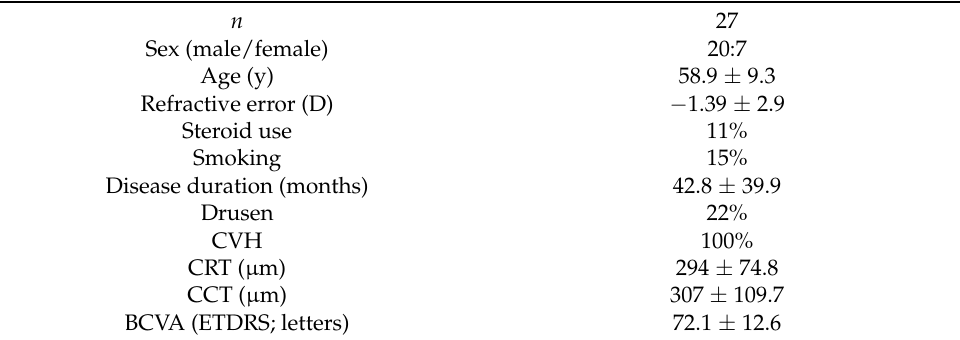
Table 1. Baseline characteristics of subjects (means ± SD).